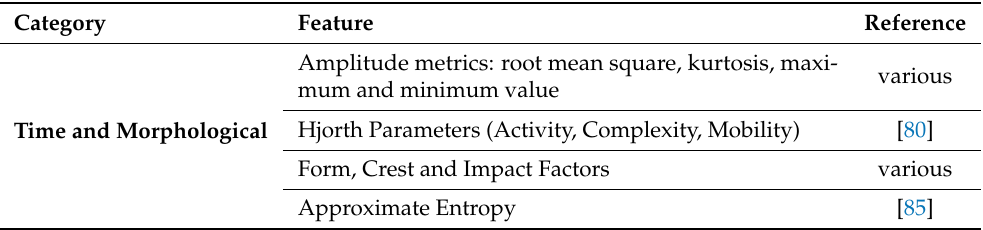
Table 4. Employed EEG features, along with the domain and proper reference. (cid:5) : adapted from the cited